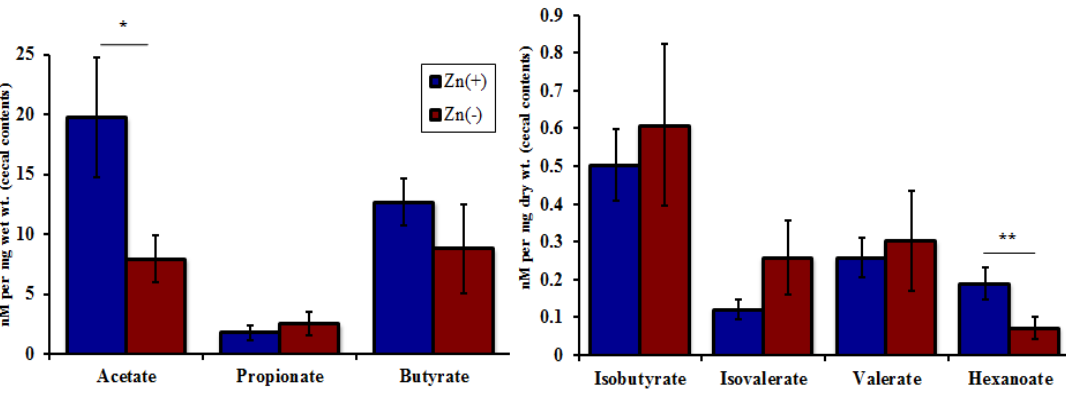
Figure 7. Concentration of short chain fatty acids (SCFAs) in the cecal contents in the Zn(+) and Zn( − ) groups (* p < 0.05, ** p < 0.01, ANOVA).